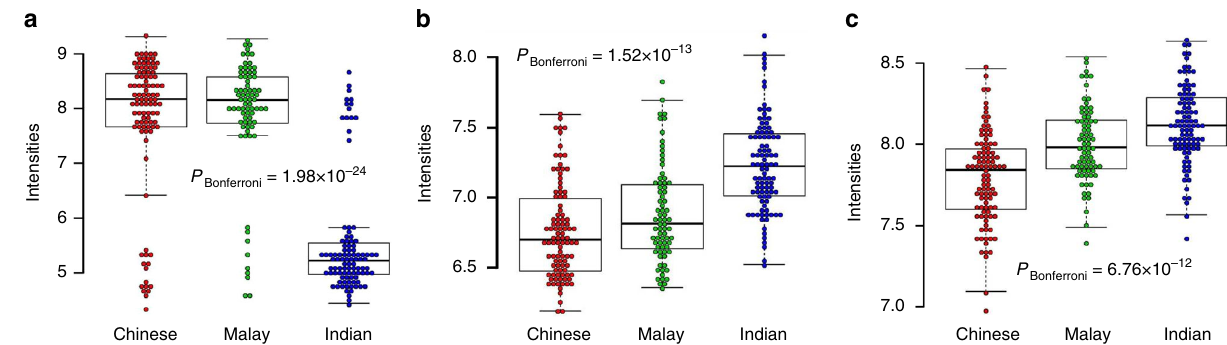
Fig. 3 A combined boxplot and scatter plot of the top three signi fi cant transcript probesets across three populations. The combined plot showing distribution of transcript intensities of a 7912136: UTS2 gene, b 8041061: PLB1 gene , c 8102362: TIFA gene across three populations. P- values were calculated using ANOVA, adjusted for batch effect and gender, and corrected for Bonferroni. The upper whisker represents either the maximum value observed or is 1.5 times the interquartile range greater than the third quartile, whichever is smaller. The lower whisker represents either the minimum value observed or is 1.5 times lower than the fi rst quartile, whichever is greater. The details of the signi fi cant transcript probesets across three populations can be found in Supplementary Data